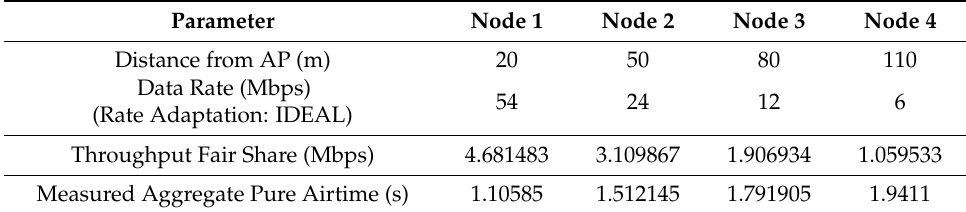
Table 3. Throughput Fair Share for TCP Traffic in the Basic Topology (4 nodes, 10